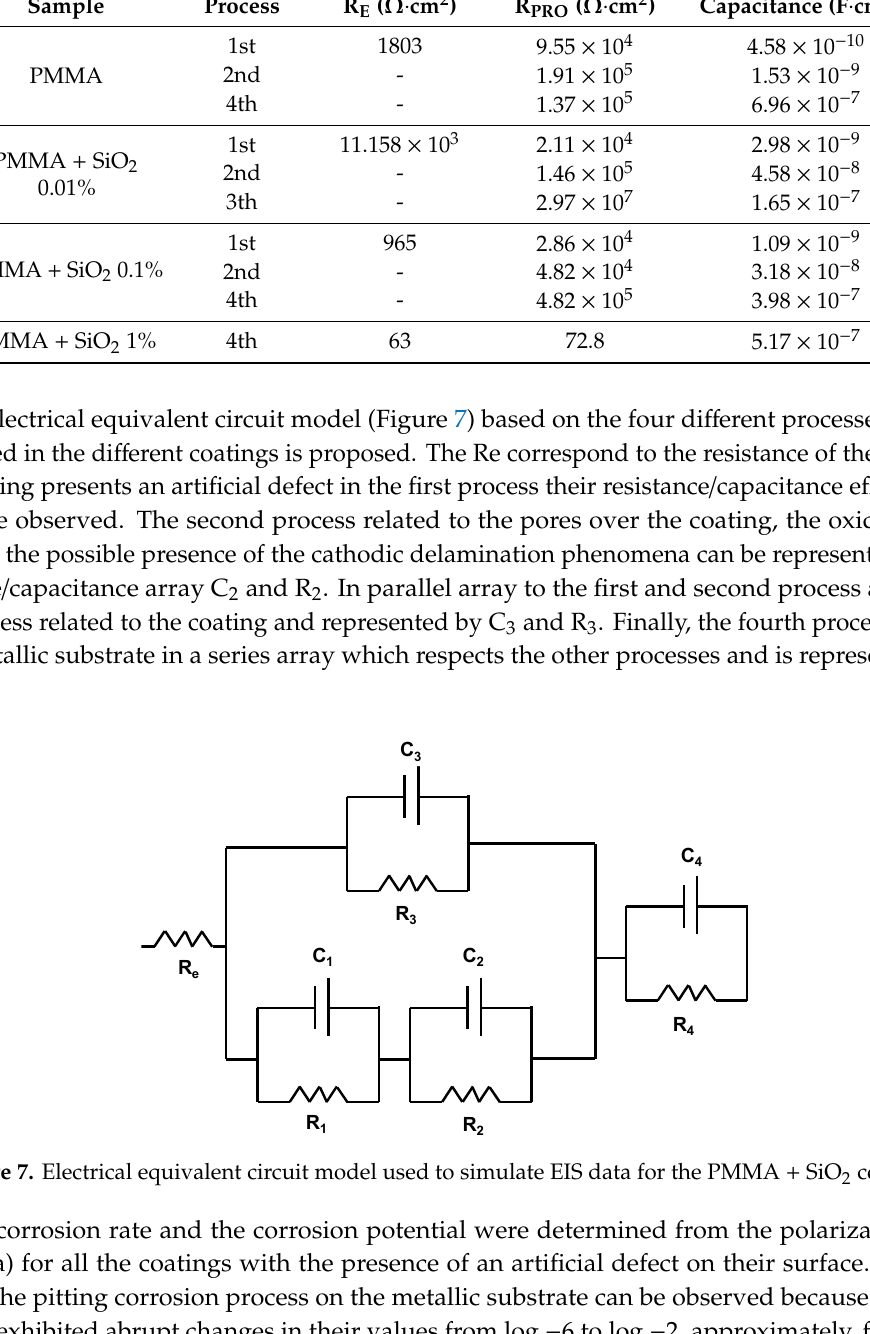
Table 2. EIS parameters for the PMMA and PMMA + SiO 2 coatings in synthetic seawater with an artificial defect on the surface.